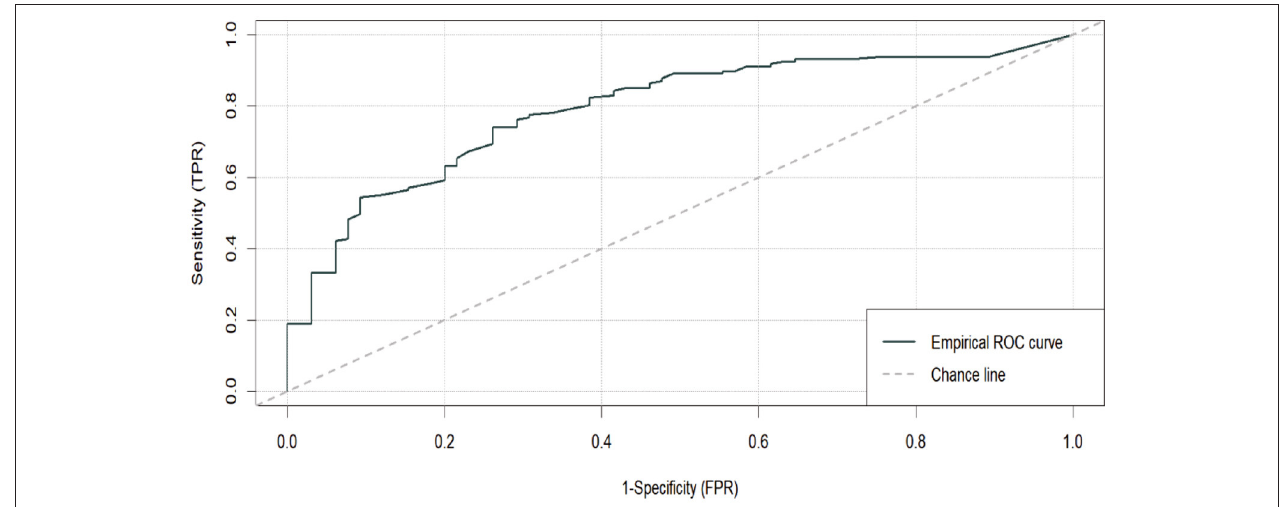
FIGURE 1 | PREVI-A ROC curve on criminal